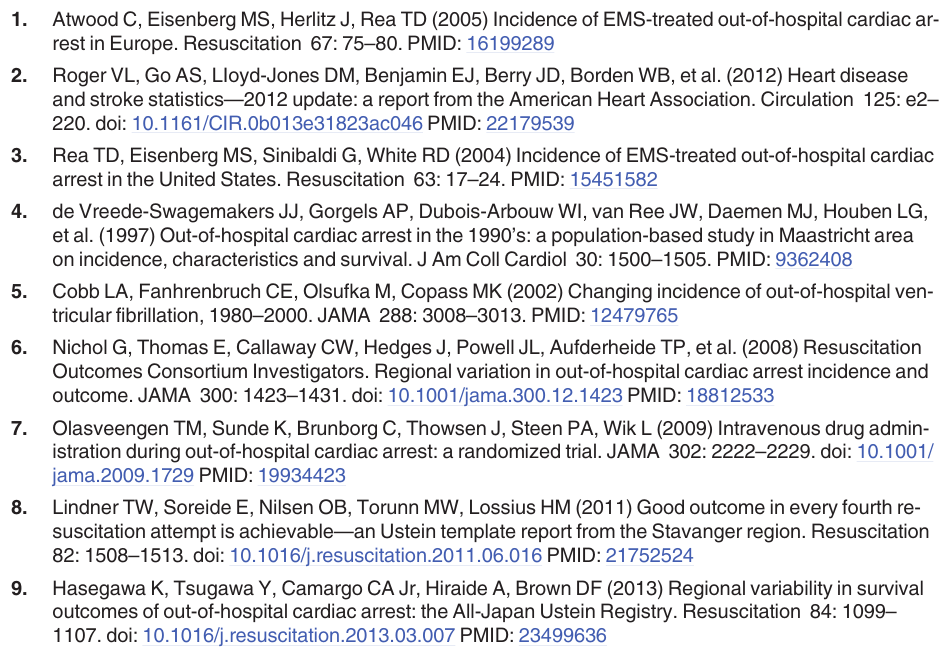
S7 Table. Linear and polynomial regression models of annual mortality rates (%) among OHCA patients, for national data of Taiwan from 2000 to 2012, by gender. S8 Table. Linear and polynomial regression models of annual mortality rates (%) among OHCA patients, for national data of Taiwan from 2000 to 2012, by age. S9 Table. Linear and polynomial regression specifications that model the annual mortality rates (%) among OHCA patients in terms of a linear combination of the time period (t) as well as an autoregressive (AR) disturbance process, for national data of Taiwan from 2000 to 2012, by gender. S10 Table. Linear and polynomial regression specifications that model the annual mortality rates (%) among OHCA patients in terms of a linear combination of the time period (t) as well as an autoregressive (AR) disturbance process, for national data of Taiwan from 2000 to 2012, by